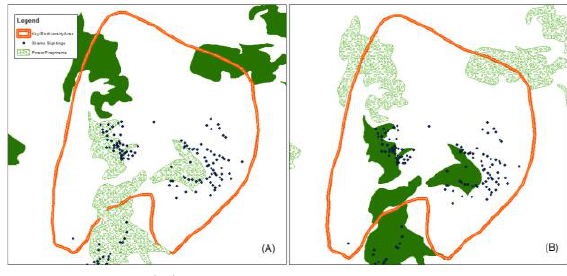
Figure 3. Map (A) shows the source forest fragments in light green while Map (B) shows the destination forest